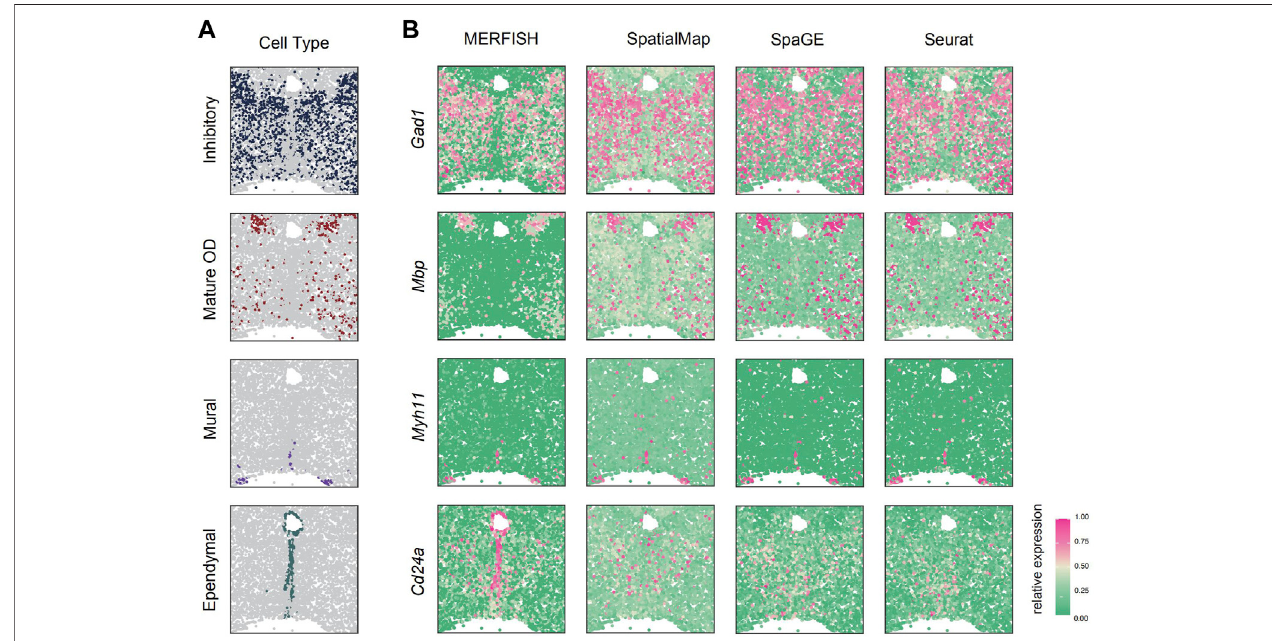
FIGURE 3 | SpatialMap accurately predicted the expression of marker genes Gad1 , Mbp , Myhh11 , and Cd24a , consistent with MERFISH-measured data. (A) Spatial distribution of four main cell classes. The cell classes are represented by colored dots, while all other background cells are shown as gray dots. (B) SpatialMap- predicted genes (thesecondcolumn) fairlyrecovertheirmeasured patterns bythe MERFISHtechnique (the fi rstcolumn) and correspond tothe distribution ofcell types. Color represents the relative gene-expression level (purple, high; green, low).